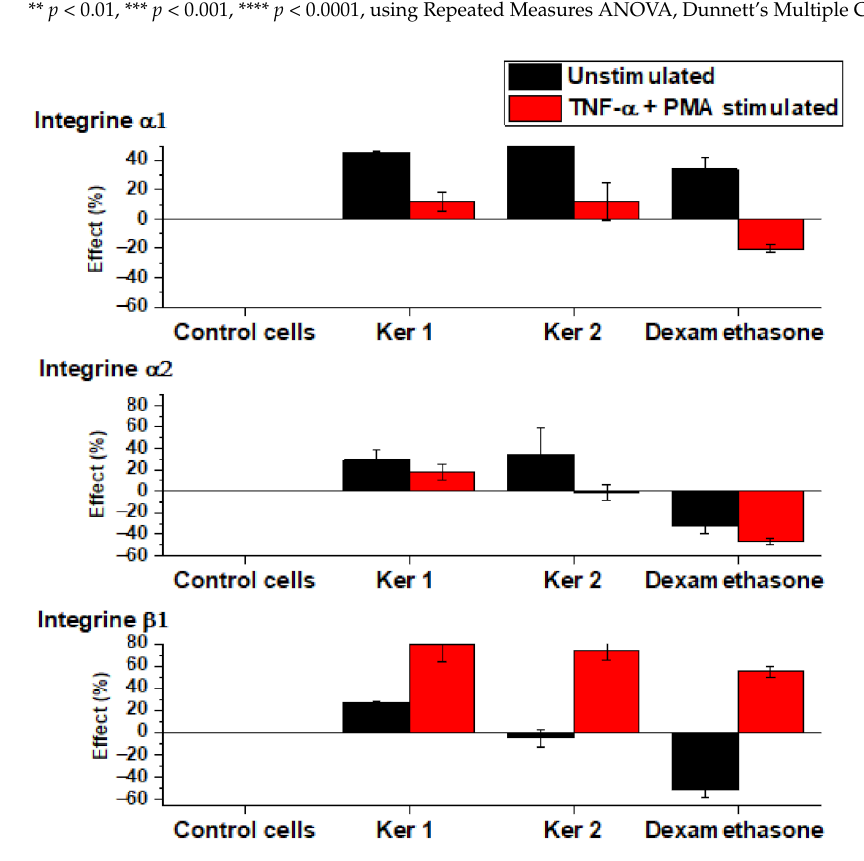
Figure 7. Percentage variation of integrins in fibroblasts compared to control cells for integrins α 1, α 2 and β 1 over-expression modulated by Ker 1 and Ker